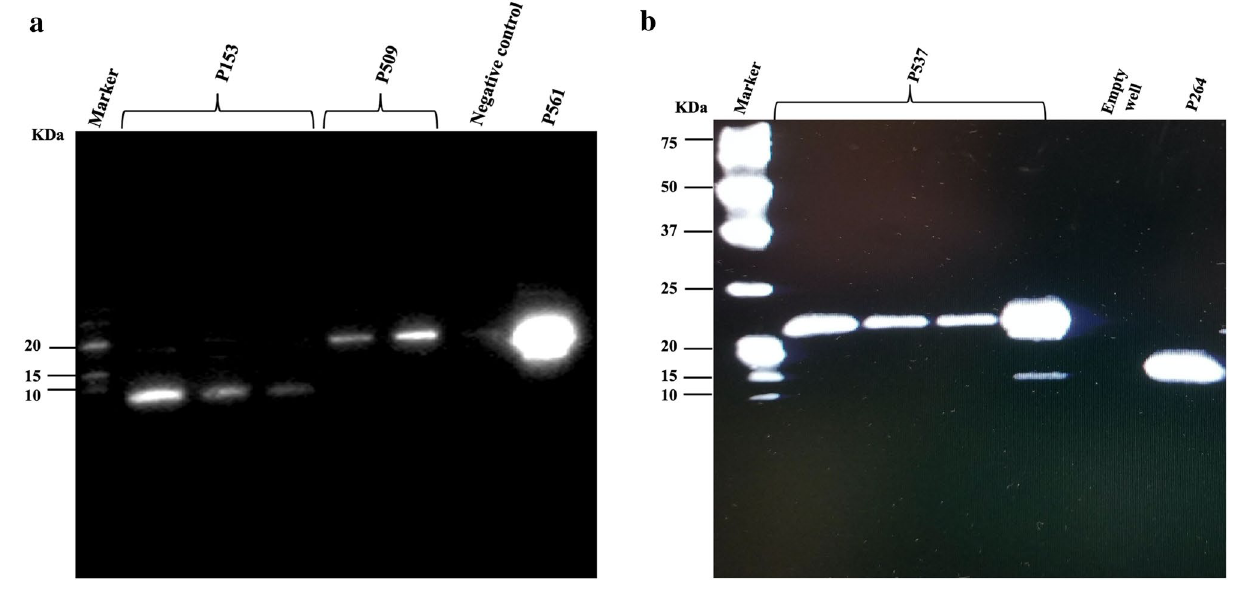
Figure 2. Western blot analysis of V5-tagged purified recombinant proteins: ( a ) P153, P509 (different fractions), Negative control, and P561 and ( b ) P537 (different fractions) and P264. Negative control sample in ( a ) consist of total cell protein samples from BL21 cells that were transformed with pET empty vector.